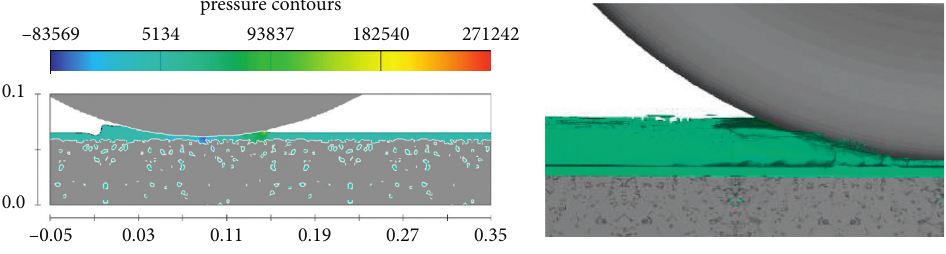
Figure 8: Simulation of pore water pressure distribution.